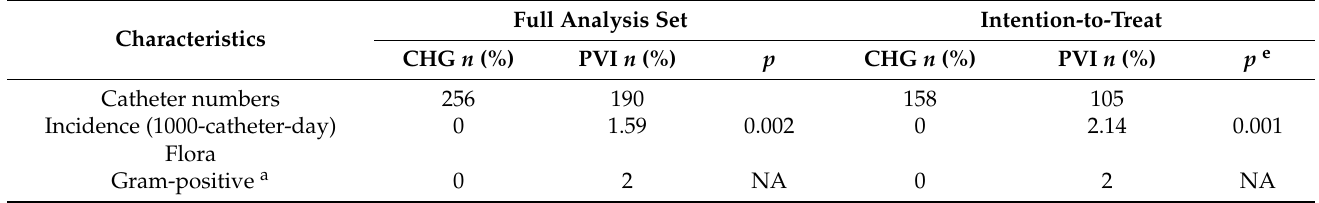
Table 2. Incidence and microbiologic features of the catheter-related bloodstream